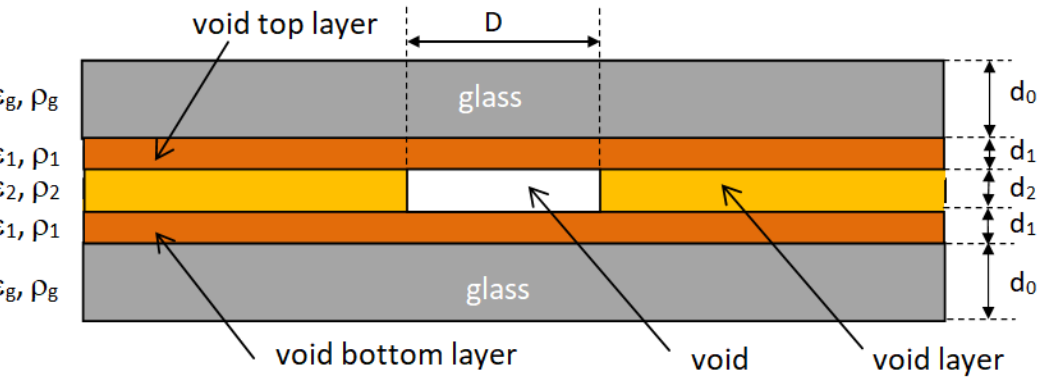
Figure 3. Dielectric layered specimen and notation, ε —dielectric relative permittivity, ρ —electric resistivity, d —thickness, D —void diameter (explanation in text).